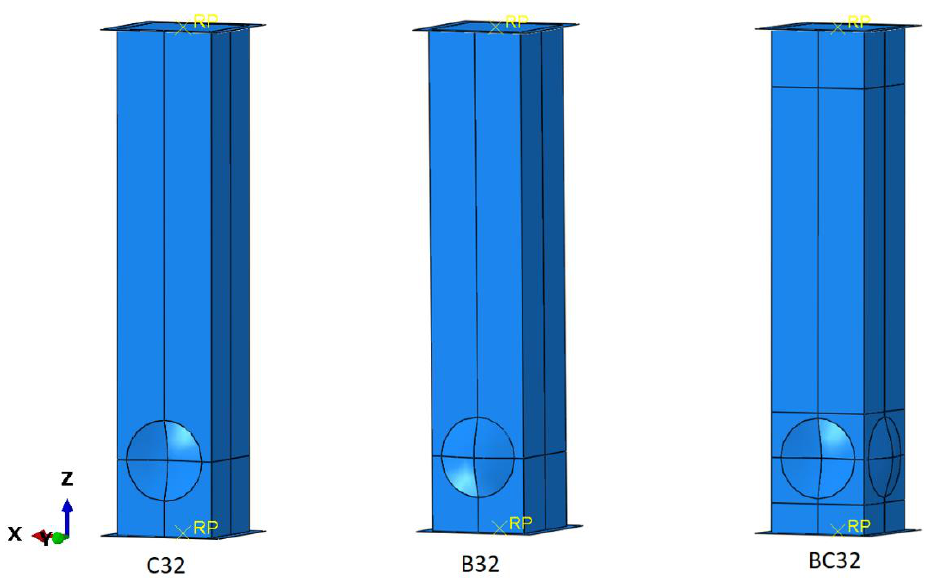
Figure 5. Types of models used in the numerical analysis.